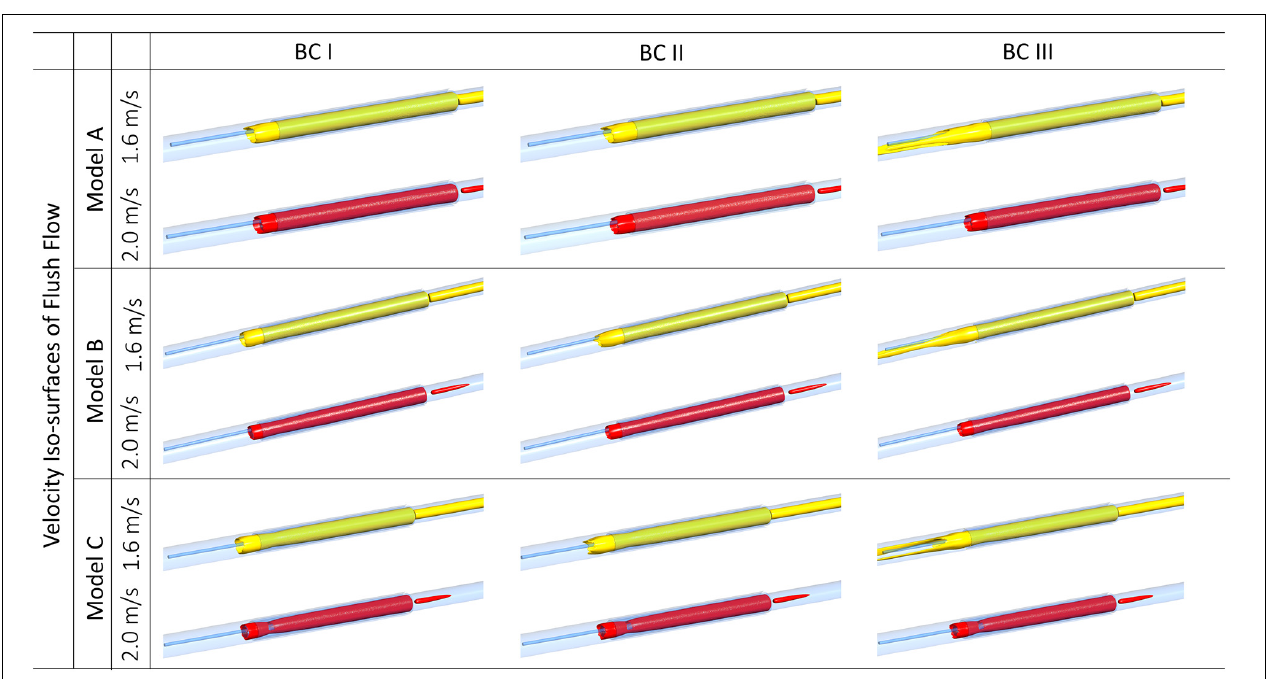
FIGURE 5 | Velocity iso-surfaces of flush flow affected by endoscope morphologies and flowrates of the background blood flow.